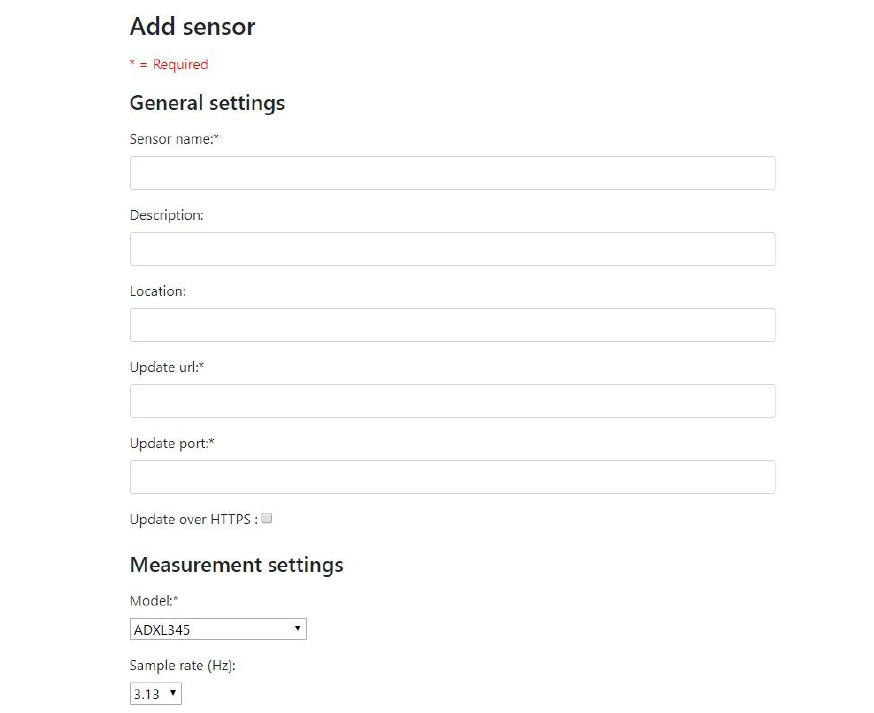
Figure 6. A part of the add sensor view.